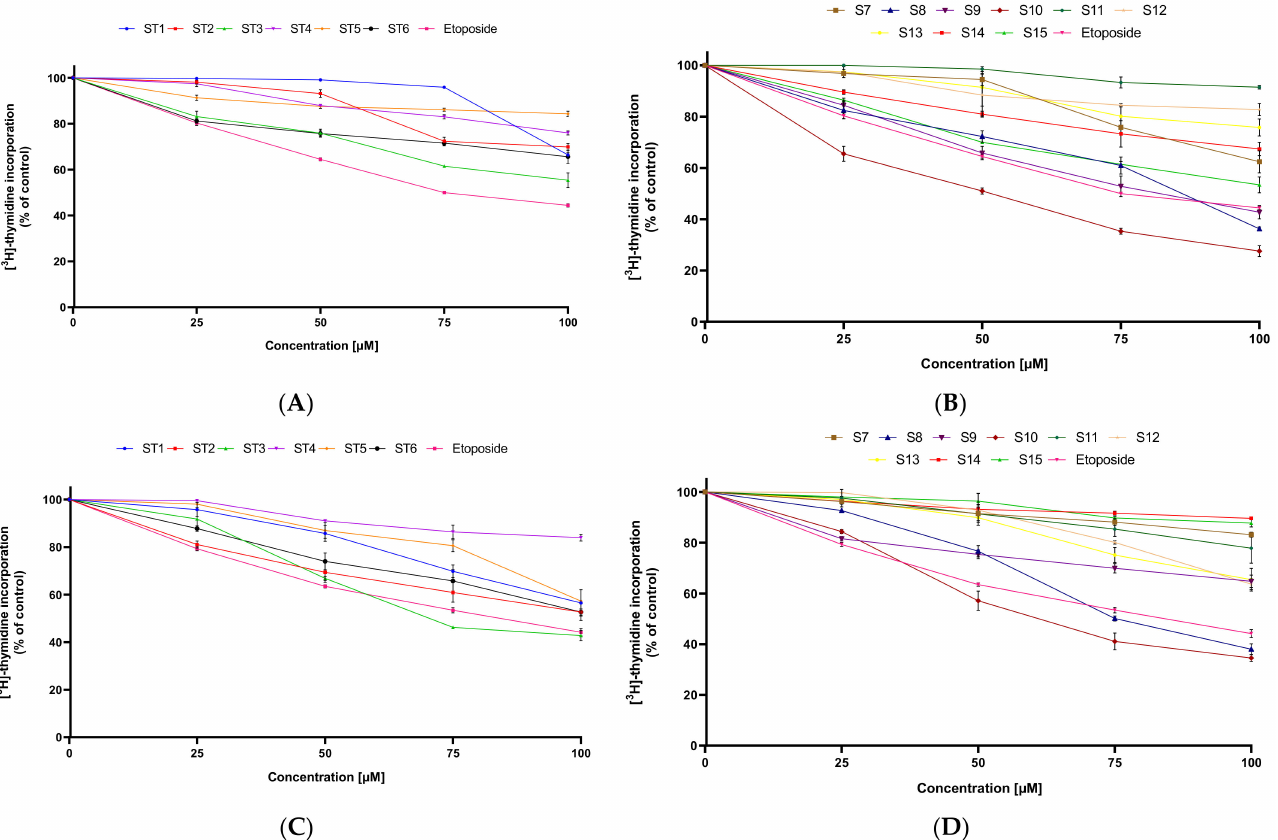
Figure 3. The anti-proliferative effect of the tested compounds ( ST1 – ST15 ) against MCF-7 ( A , B ) and MDA-MB-231 ( C , D ). Mean ± SD values from three independent experiments ( n = 3) done in duplicate are